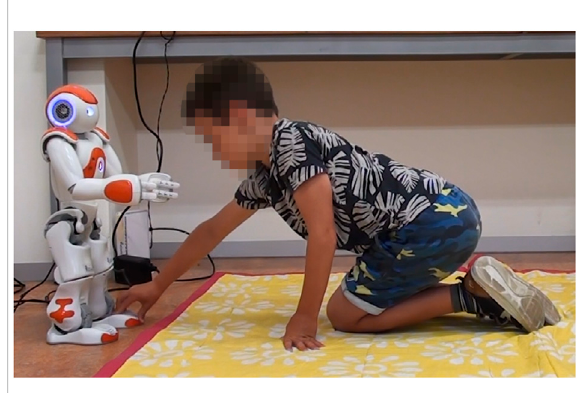
FIGURE 3 Child pressing one oftheanswer bumpers on theNao